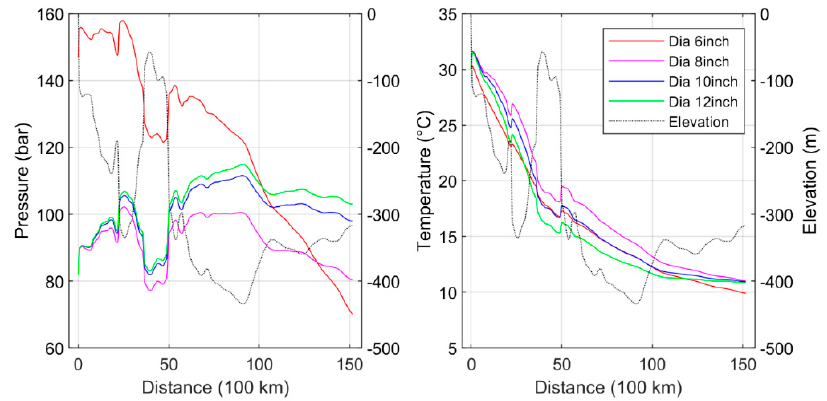
Figure 10. Summary of Pipeline Temperature and Pressure Profiles for the Melkøya CO 2 Pipeline Example for the 10% reservoir overpressure case.